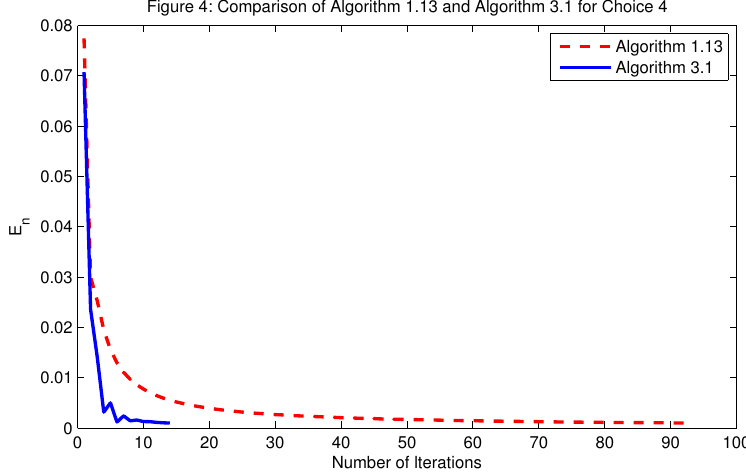
Figure 4. Comparison of Equations (13) and (25) for each choice